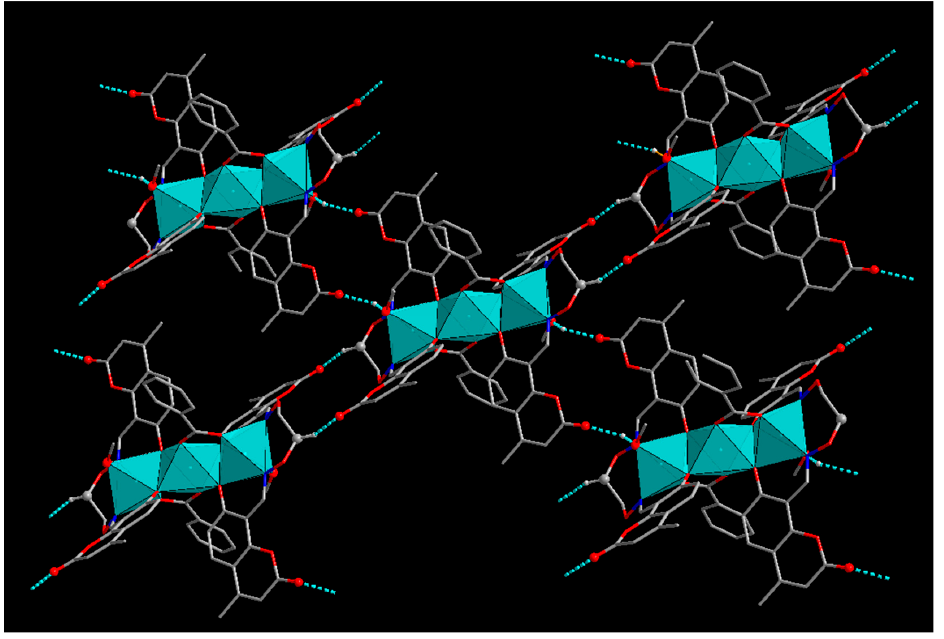
Figure 13. View of the two-dimensional supra-molecular structure of complex 3 exhibiting the O-H···O, C-H···O hydrogen bonding interactions.